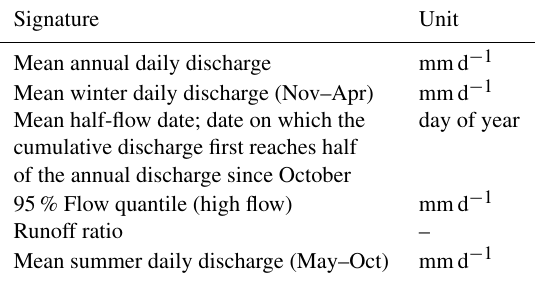
Table 1. Applied hydrological signatures on the discharge data of the CAMELS (Addor et al.,